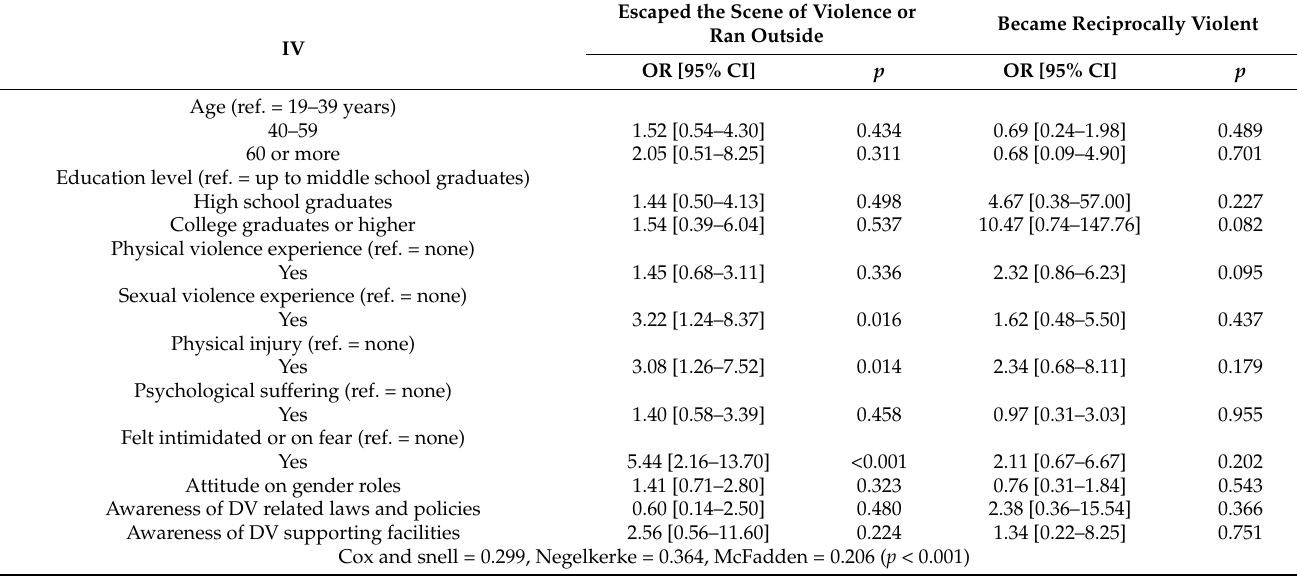
Table 3. Factors associated with DV-related coping behaviors ( n =